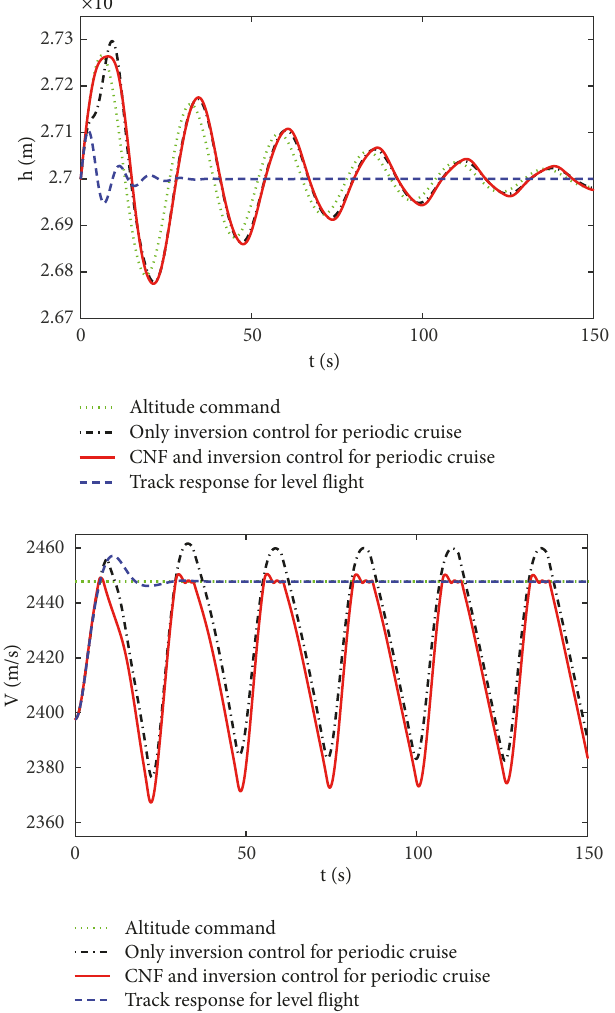
Figure 8: Response curves in relation to level flight and periodic cruise between with CNF and without